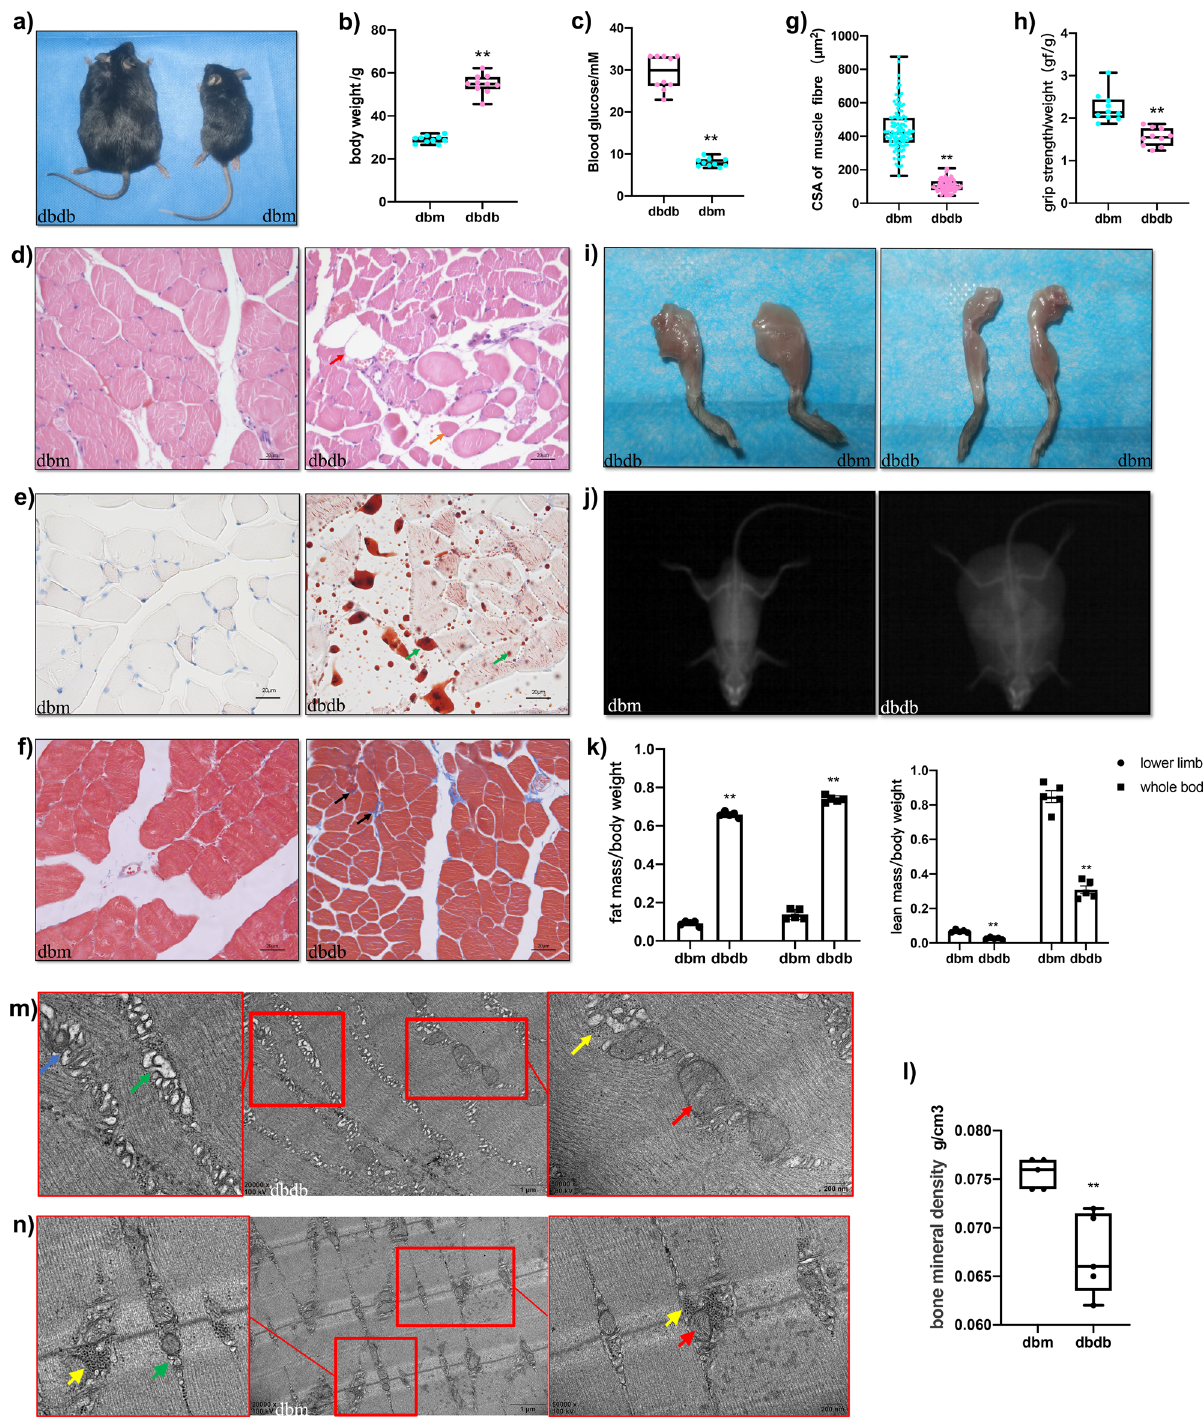
Fig. 1 A metabolic disorder, loss of muscle mass and strength, and structural abnormalities are evident in the diabetic muscle atrophy model of db/db mice. Compared to db/m group, db/db mice extremely developed obesity ( a , b ), hyperglycaemia ( c ) ( n = 10). H&E ( d ), Oil-red O staining ( e ), and Masson staining ( f ) in GAS of db/db and db/m group. Scale bar, 20 μ M. Red arrow indicates adipocytes; orange arrow indicates atrophic myo fi bres; green arrows indicate lipid droplets; black arrows indicate muscle fi brosis. g Quantitative analysis of the average cross-sectional area (CSA) of myo fi bres. h The forelimb grasping strength and i muscle mass and size of lower limbs were decreased in db/db mice compared with db/m mice. The whole-body composition analysis of dual ‐ energy X ‐ ray absorptiometry (DEXA) ( j ) displayed more fat mass, less lean mass ( k ) and decreased bone mineral density (BMD) ( l ) in db/ db vs. db/m ( n = 5 replicates). Transmission electron microscopy (TEM) of GAS from db/db and db/m mice ( m , n ). The long red arrow indicates mitochondrial abnormalities and the short one indicates normal mitochondria; the blue arrow indicates myelinbody; the yellow arrows indicate muscular glycogen; the long green arrow indicates swelling endoplasmic reticulum and the short one indicates normal endoplasmic reticulum. Data were expressed as mean ± S. D. * P < 0.05 ** P < 0.01. Note: H&E: haematoxylin and eosin; GAS: gastrocnemius; CSA: average cross-sectional area; DEXA: dual ‐ energy X ‐ ray absorptiometry; BMD: decreased bone mineral density; TEM: Transmission electron microscopy.